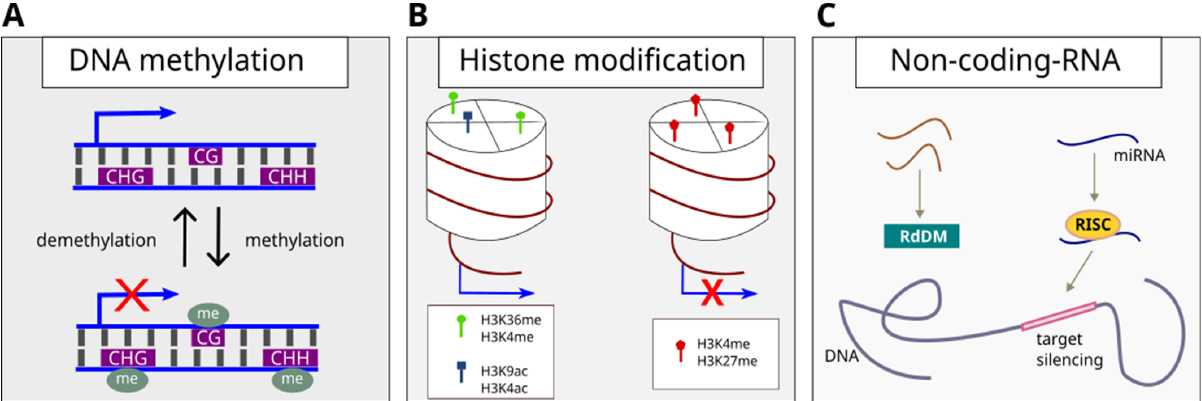
Figure 1. Epigenetic changes contributing to the plasticity characteristics in a plant to stressful en ‐ vironmental conditions (adapted from Villagómez ‐ Aranda et al. [78] and Thiebaut et al. [79]). ( A ) DNA methylation. The process involves attaching a methyl group to the 5th carbon of cytosine in DNA. In plants, methylation occurs in three sequence contexts: CG, CHG, and CHH, where H = A/T/G. ( B ) Modifications of histones, involve post ‐ translational modifications of the histone tails, mainly methylation and acetylation. It is assumed that on histone H3, methylation of lysine 4 and 36 and acetylation of lysine 4 and 9 is responsible for enhancing gene expression, while methylation of lysine 9 and 27 contributes to the inhibition of the expression of selected genes. ( C ) Non ‐ coding RNAs. Small, about 20 nucleotide RNA molecules that do not code proteins, but regulate gene ex